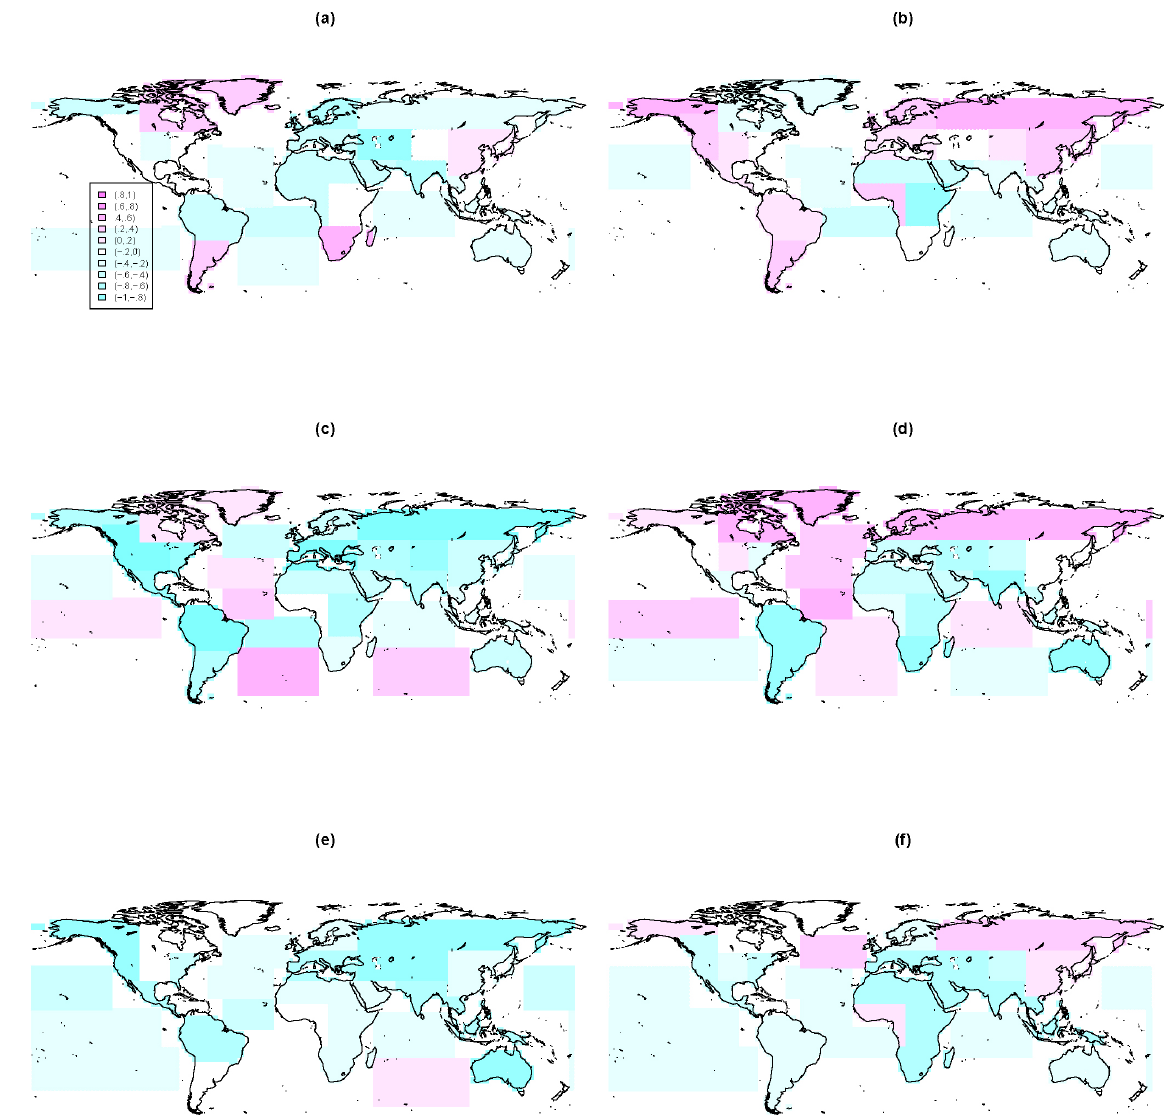
Figure 11. Correlation coefficient maps: (a) JJA and (b) DJF for NCEP/GPCP, (c) JJA and (d) DJF for GFDL, and (e) JJA and (f) DJF for